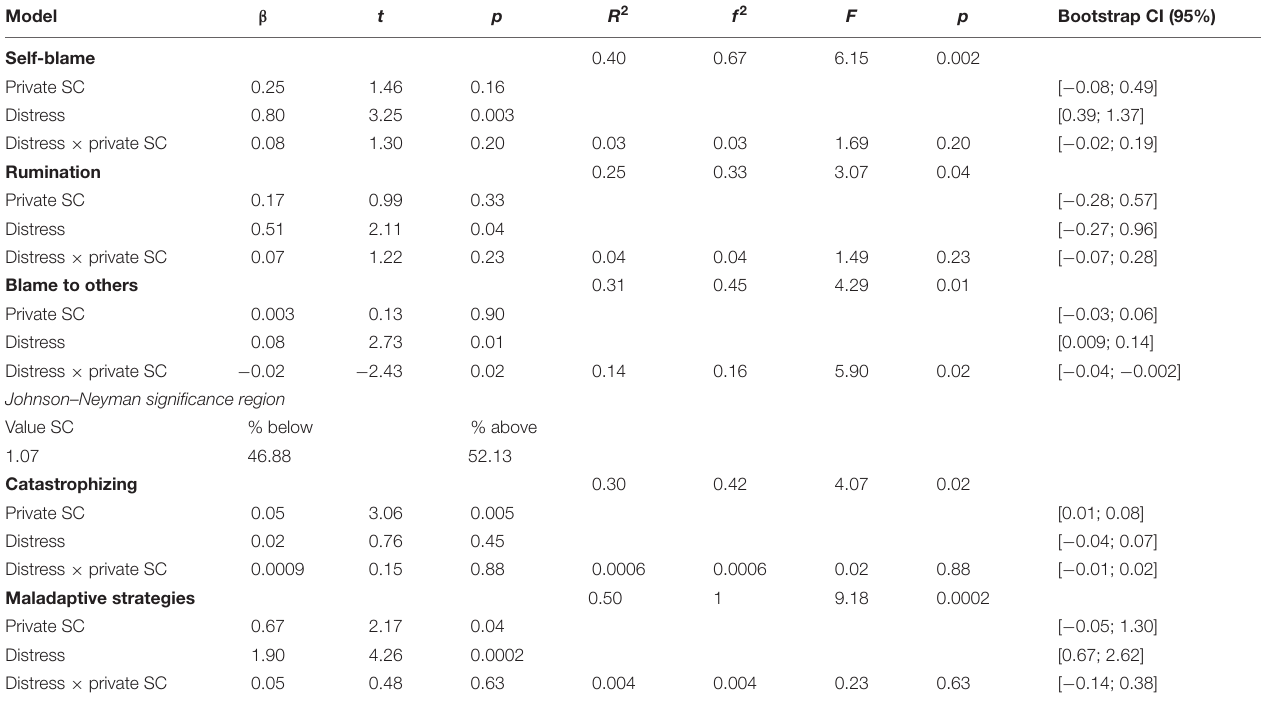
TABLE 3 | Multiple regression analyses predicting maladaptive emotion regulation strategies as a function of private SC, distress and their interaction in the binge drinking group.